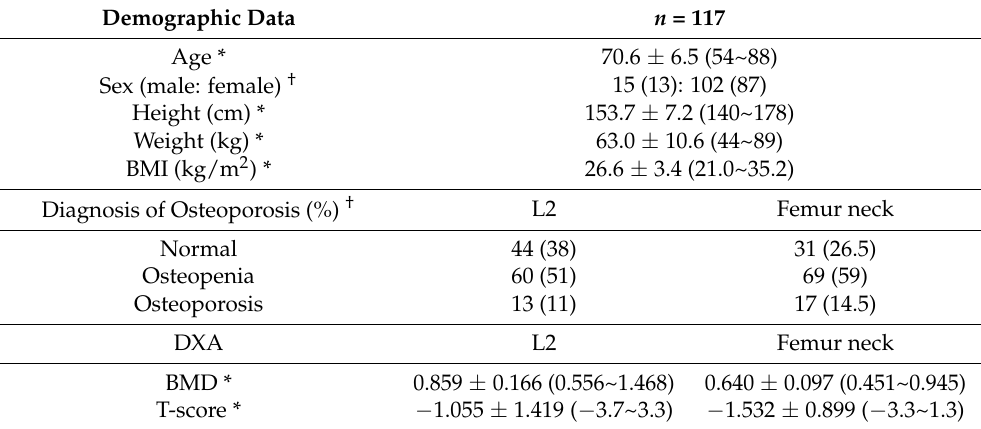
Figure 1. Standards for Reporting of Diagnostic Accuracy Studies (STARD) flow chart of patient inclusion. Table 1. Patient demographics and preoperative